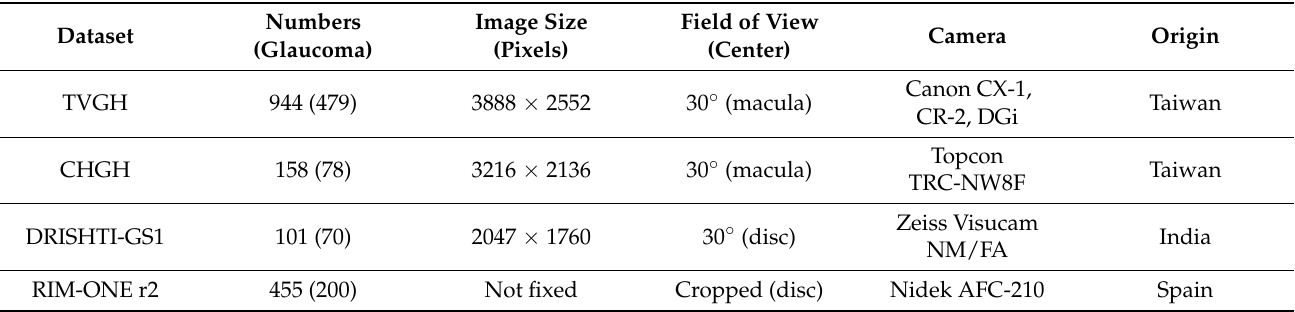
Table 1. Characteristics of the datasets used in this